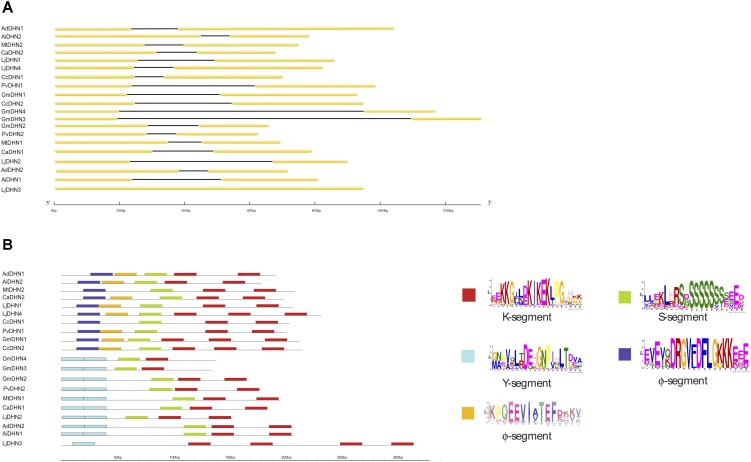
Gene and protein organization of the 20 DHNs in eight Fabaceae species. (A) Exon/intron organization of the DHN genes; (B) Motif organization and conserved segments of the DHN proteins represented by different colors (left) and their corresponding motif logos (right). The scale length is represented in base pairs (bp) and amino acids.